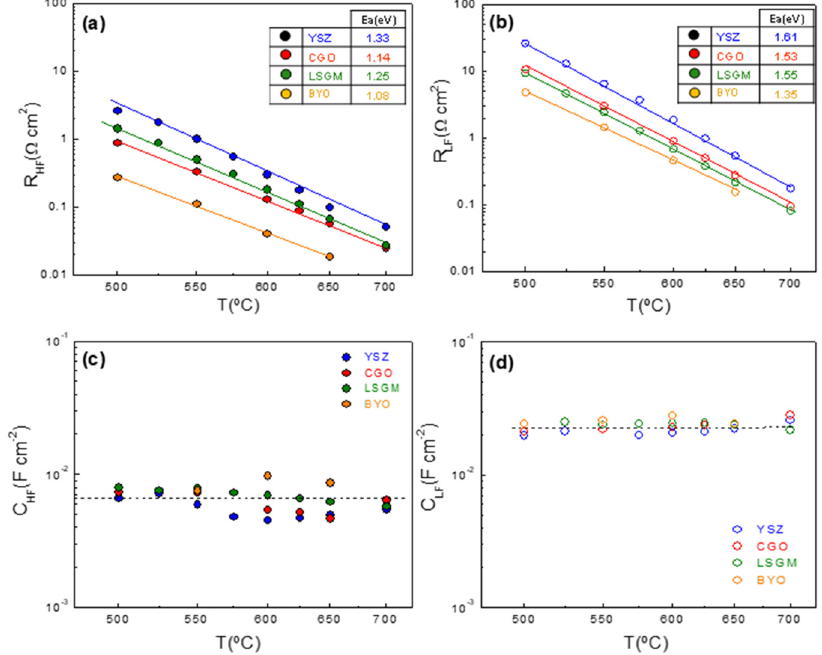
Figure 4. Temperature dependence of ( a ) R HF and ( b ) R LF resistance and ( c ) C HF and ( d ) C LF capacitance contributions of LSCF electrodes deposited on different electrolytes.